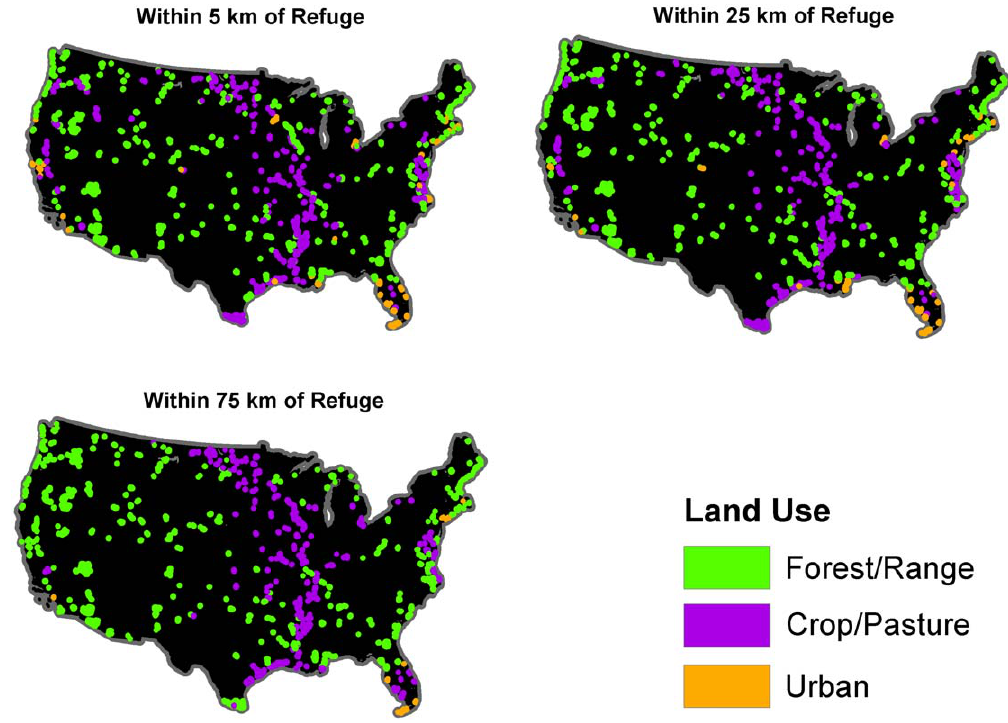
Figure 1. Current dominant land use around each National Wildlife Refuge in the contiguous 48 states.